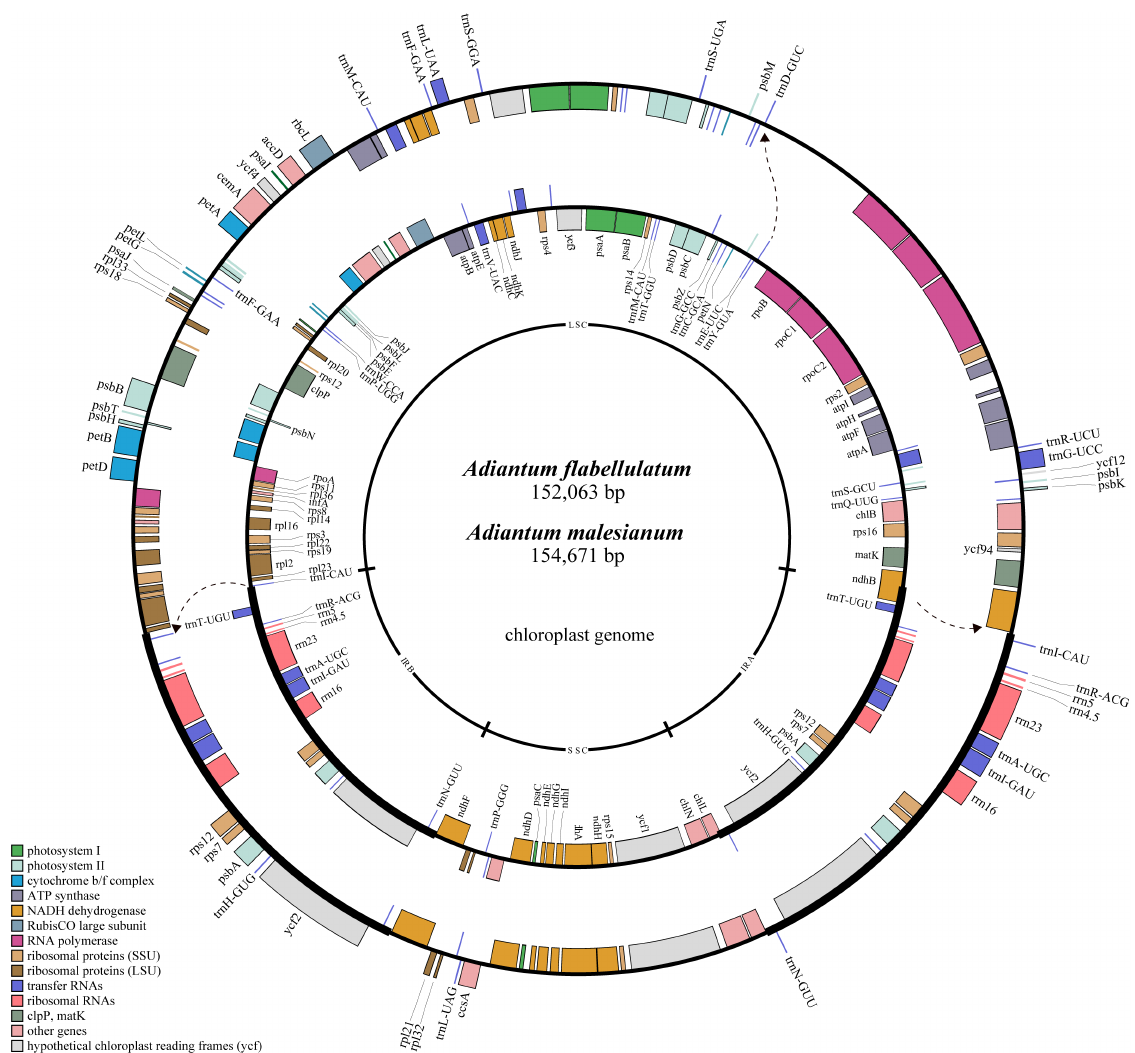
Figure 1. Gene map of A. flabellulatum and A. malesianum cp genomes. The inner circle is A. flabellula- tum , while the outer is A. malesianum . Genes on the inside of the circle are transcribed clockwise, while those on the outside are transcribed counter-clockwise. Genes are color-coded based on functions. The dotted arrows indicate the position shift of the same gene in two cp genomes. The thicker black line represents the IRs. Names of the same genes in the two cp genomes are displayed only